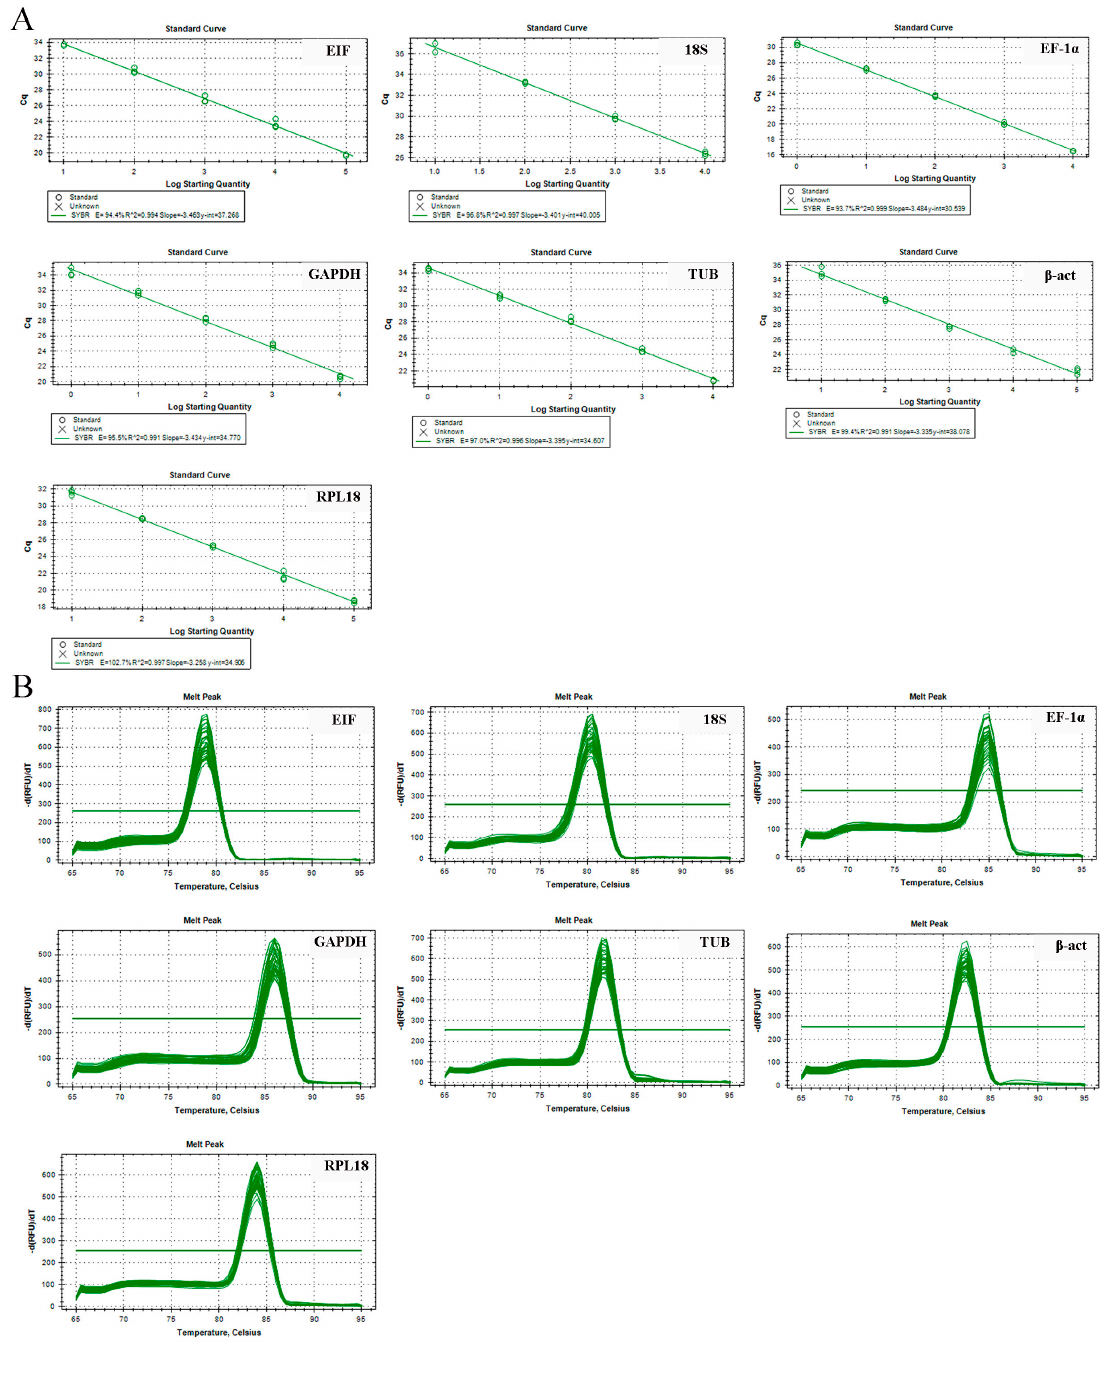
Figure 2. Dissolution and standard curve to verify the gene amplification efficiency and uniformity. ( A ) Dissolution curve of candidate reference genes. ( B ) Standard curve of candidate reference genes.